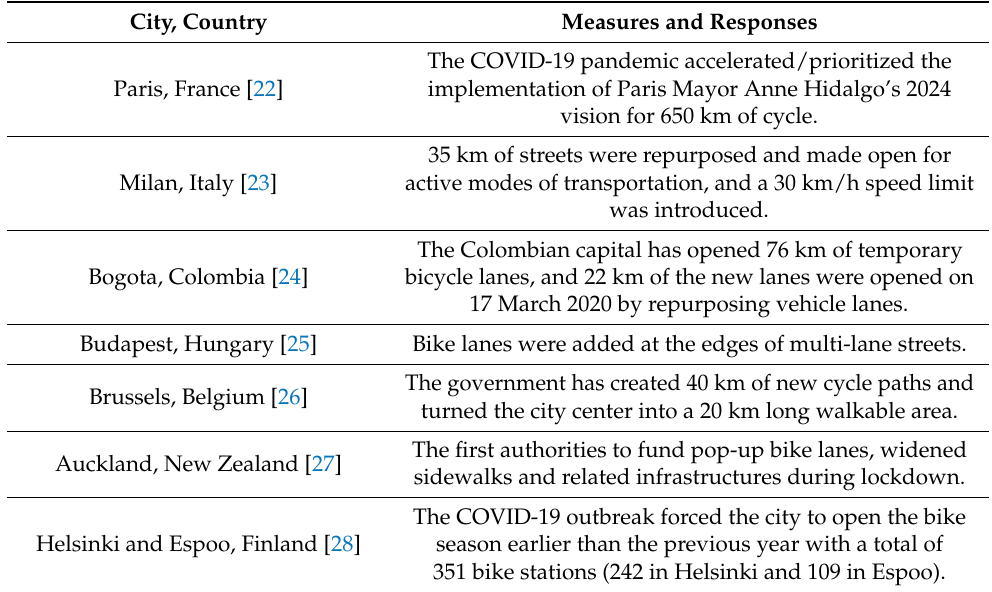
Table 1. Summary for mobility policy measures and